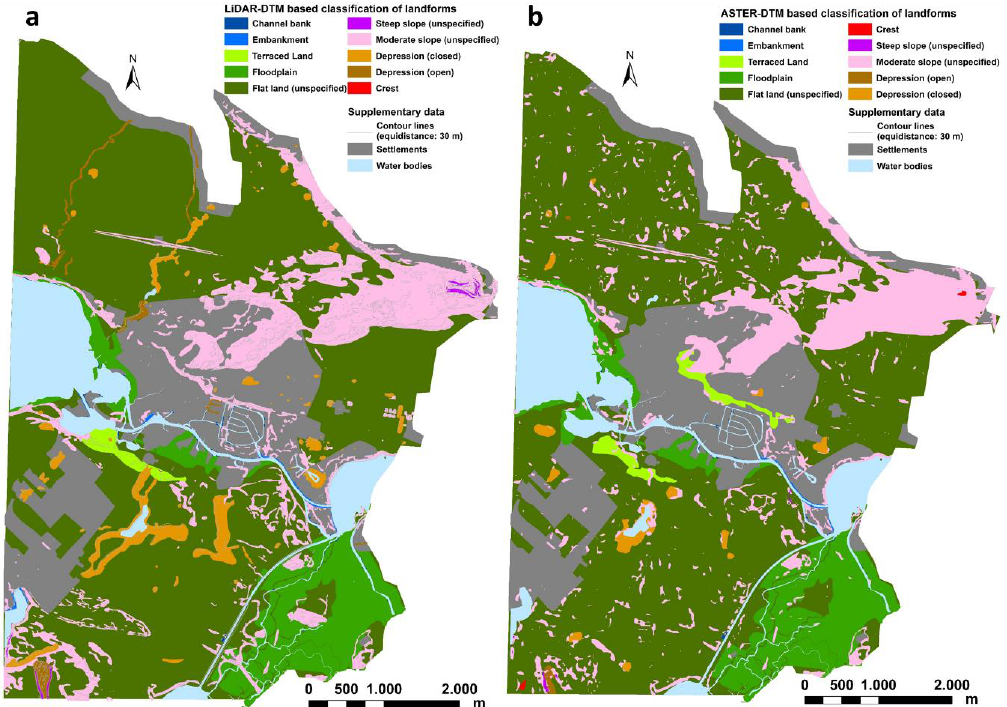
Figure 9. Map of classification results based on a LiDAR-DEM ( a ) and an ASTER-DEM ( b ) for landforms in the city area.